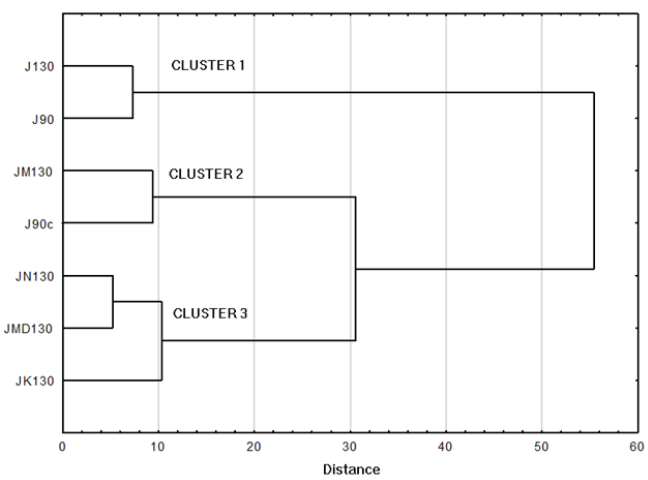
Figure 5. HCA classification of the powders based on powder recovery and the physical properties of the powders.